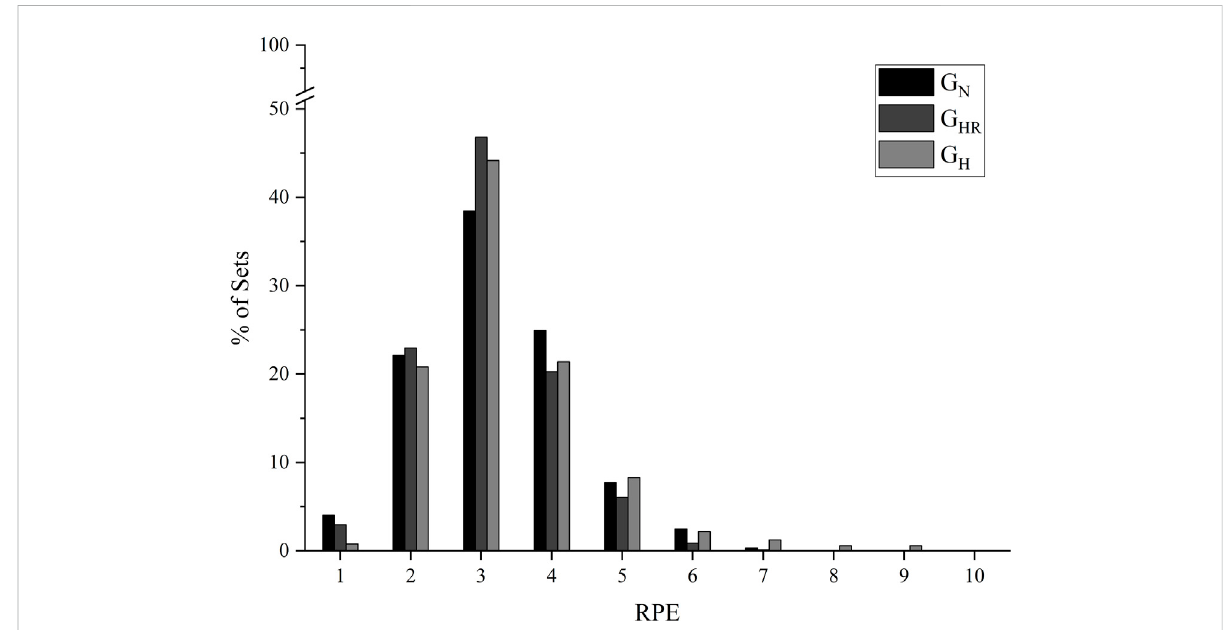
FIGURE 3 Frequency and distribution of the rate of perceived exertion (RPE) in the main part of exercise from the 8 weeks of intervention. G N = group in normoxia; G HR = group in hypoxia recovery; G H = group in hypoxia.